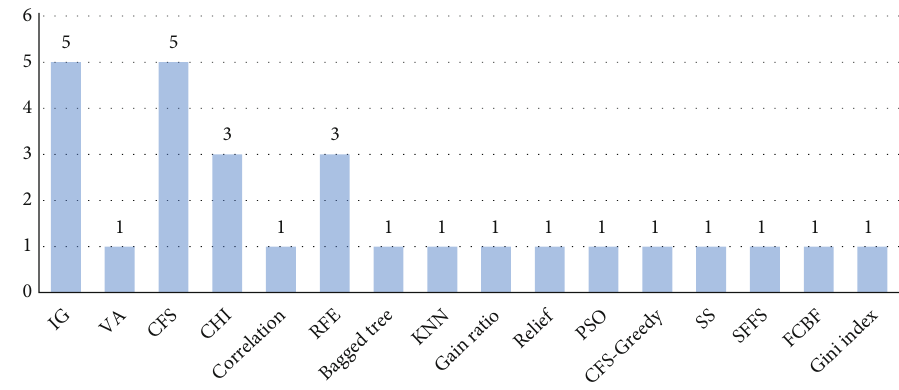
Figure 11: Description of features selection methods used in the